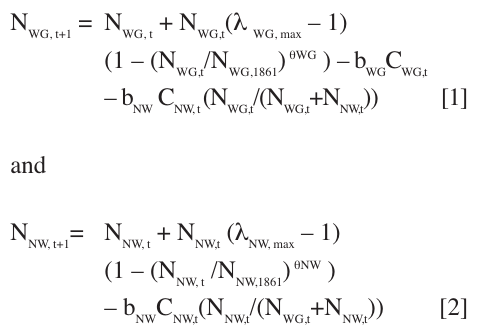
Table 2 . Index estimates of the number